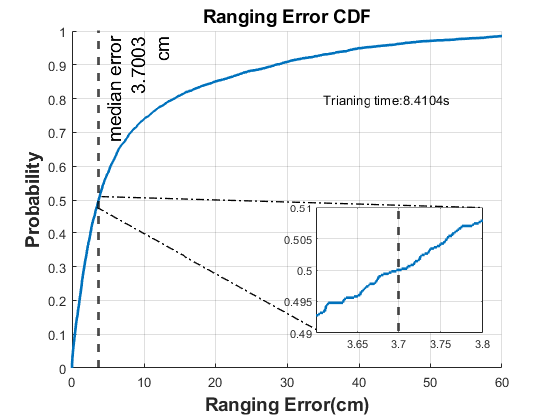
Figure 8. Ranging error